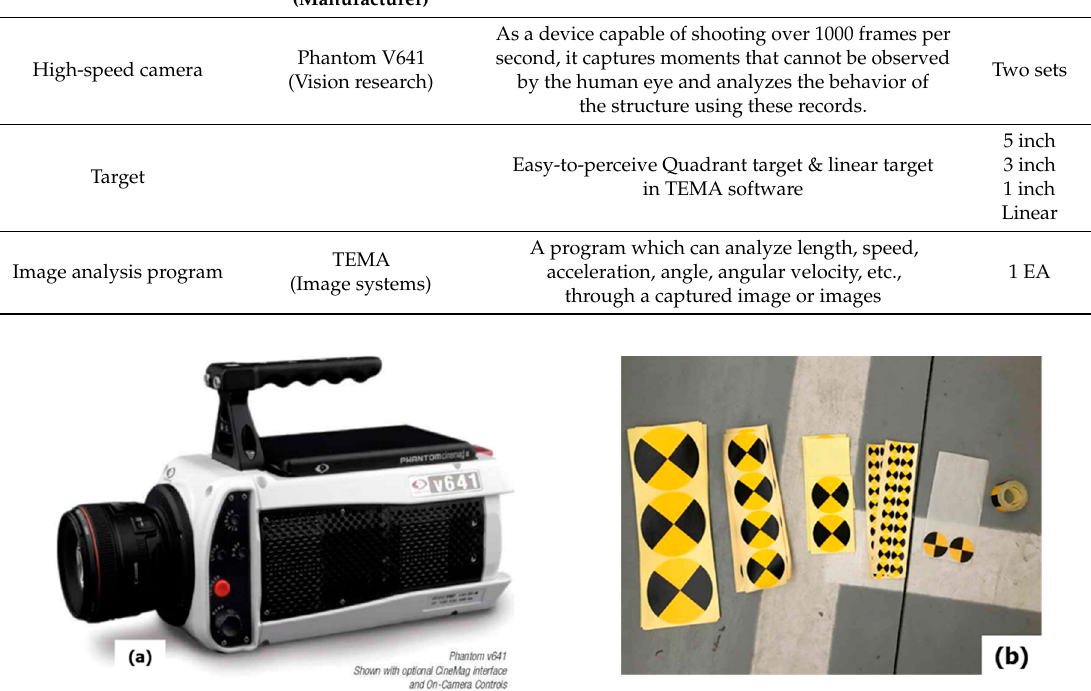
Figure 4. Pictures of ( a ) high-speed camera; ( b ) targets.